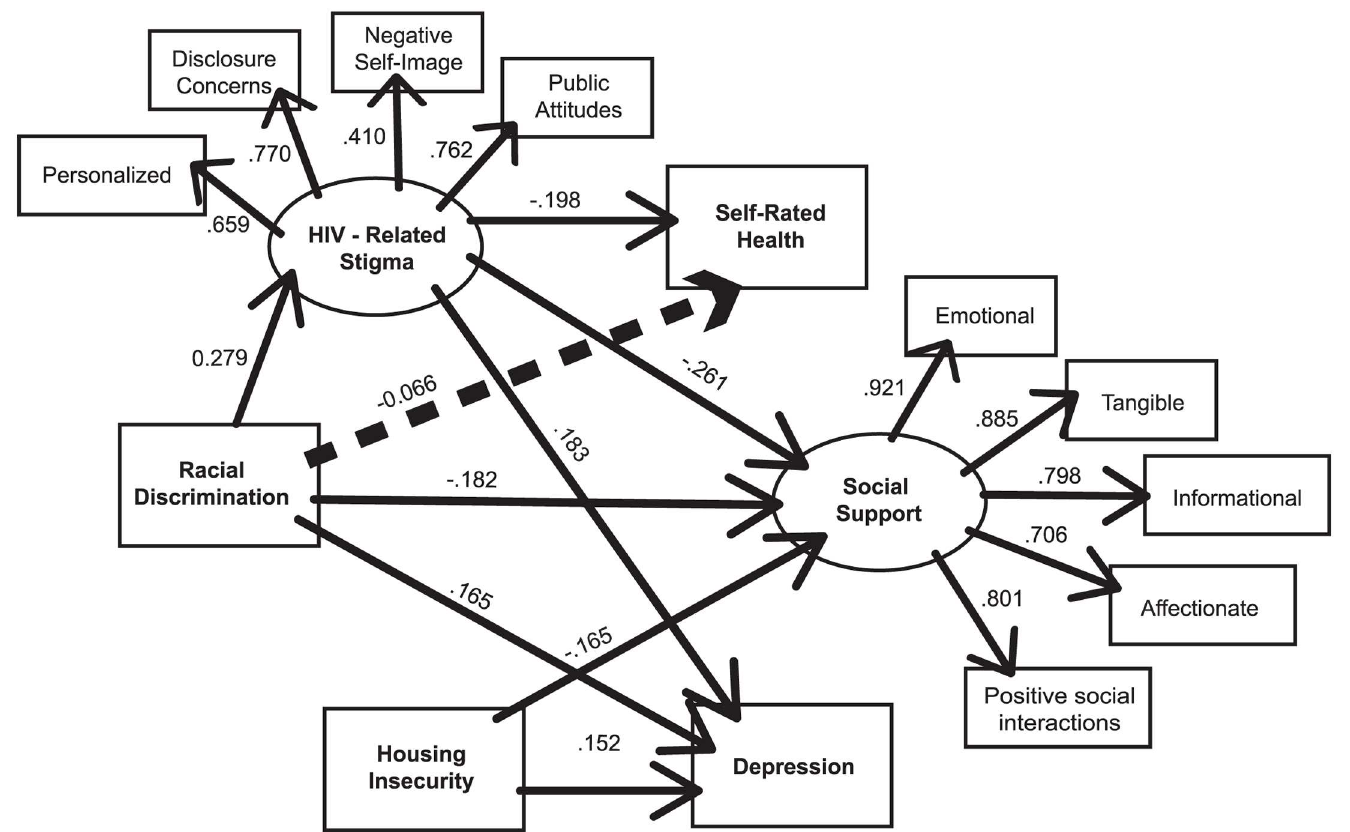
Fig 2. Final model of the relationship between HIV-related stigma, racial discrimination, housing insecurity and wellbeing among African and Caribbean women living with HIV in Ontario (n = 157). Fig 2 depicts the relationships between the latent variables (depicted as ovals) and observed variables (depicted as rectangles). Solid lines represent statistically significant direct effects and dotted lines represent statistically significant indirect effects. The standardized path coefficients next to each arrow reflect the strength and direction of the effect between variables,and the coefficient is similar to standardized beta weights in